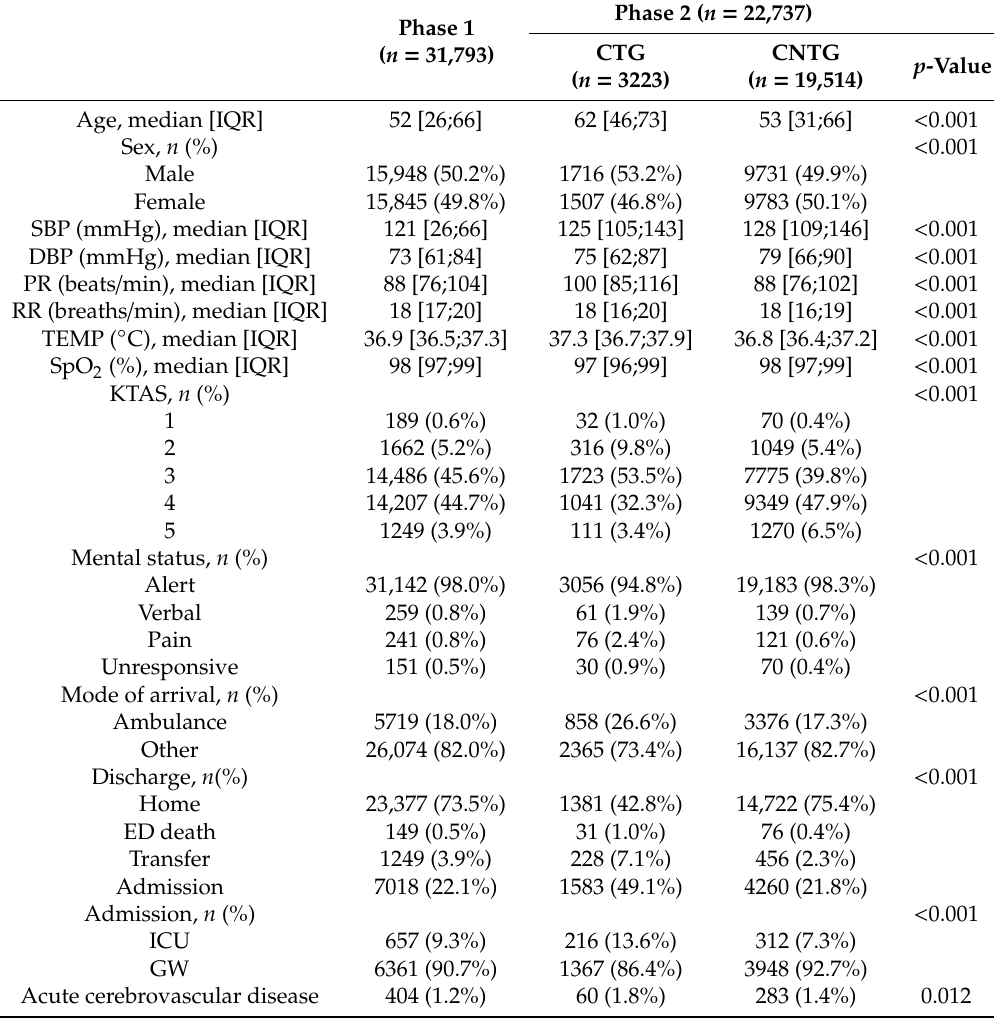
Table 1. Basic characteristics of the study